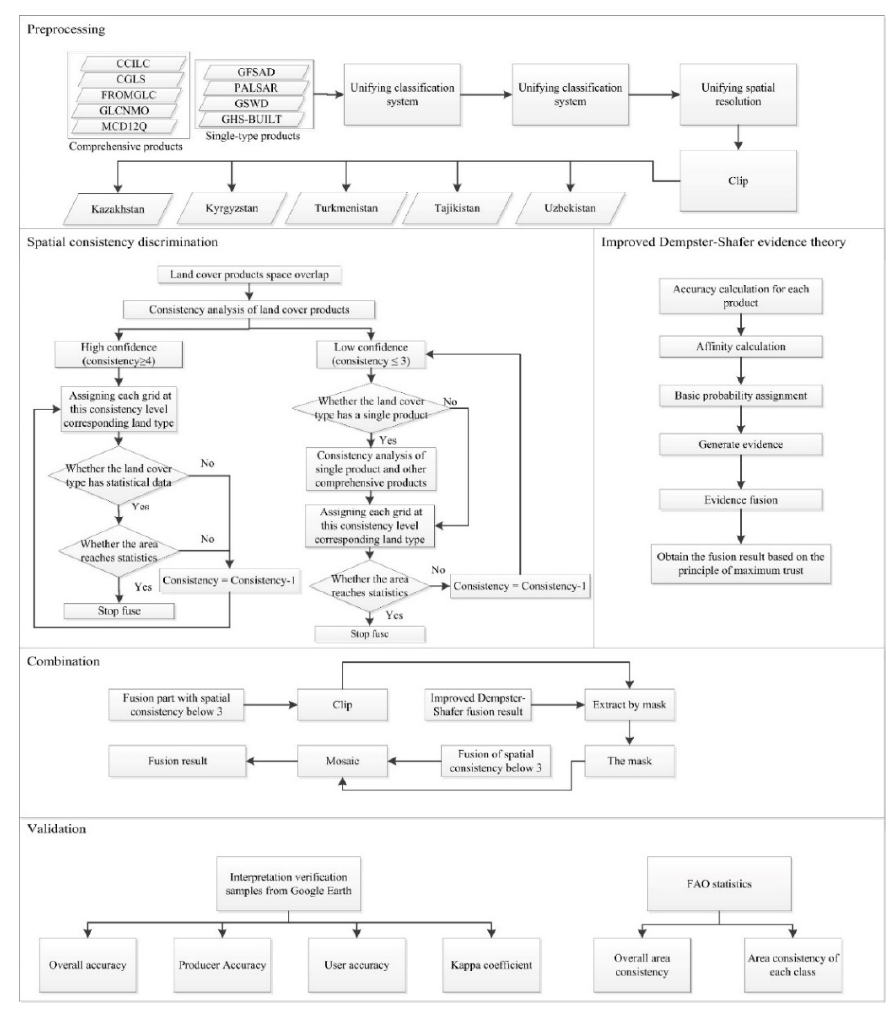
Figure 2. Flow chart of multi-source landcover product integration and modification.